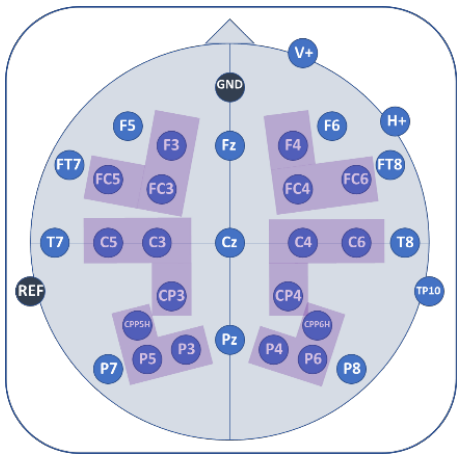
Figure 5. Electroencephalography (EEG) electrode placement. Colored areas indicate analyzed regions of interest (ROIs); consisting of three electrodes each.